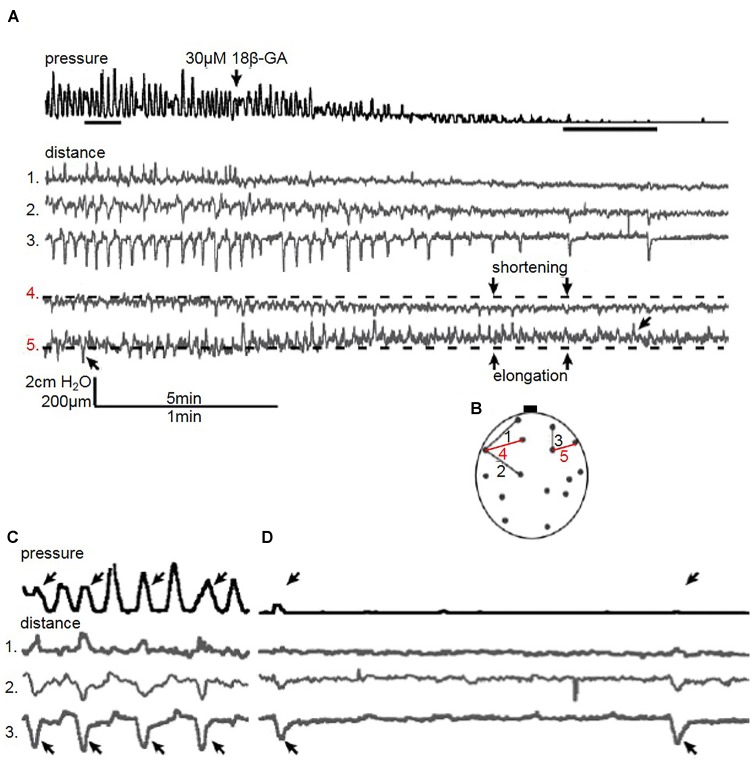
(A) A representative trace of the effect of 18β-GA (30 μM) on spontaneous pressure fluctuations in an isolated whole rat bladder, and the effect on longitudinal (distances 1, 2, and 3) and transverse (distances 4 and 5) components. Distance 4 shortens whilst distance 5 elongates, as demonstrated with respect to baseline – arrows in distance 5 demonstrate shortening and elongating events. (B) Schematic diagram depicting measured longitudinal and transverse distances. (C) Control spontaneous pressure fluctuations – arrows in pressure and distance 3 highlight pressure changes displayed by the shortening of distance 3. (D) The effect of 18β-GA (30 μM) on spontaneous pressure fluctuations – arrow in pressure and distance 3 demonstrate shortening movement of distance 3 without measurable pressure change.